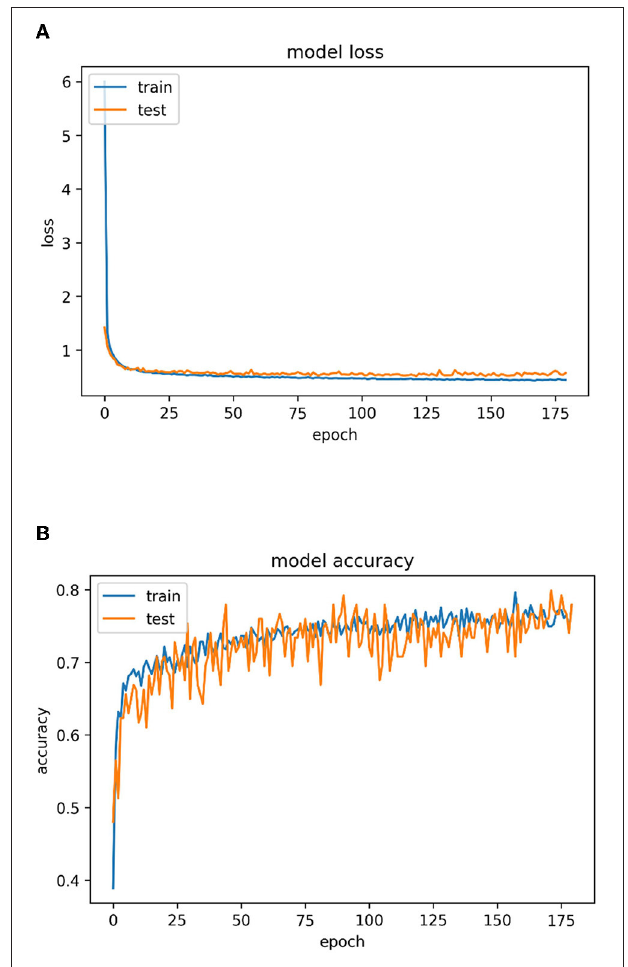
FIGURE 12 | (A) Epoch vs. loss graph for multi-stage heterogeneous stacking ensemble classification model 2 and (B) epoch vs. accuracy for multistage heterogeneous stacking ensemble classification model